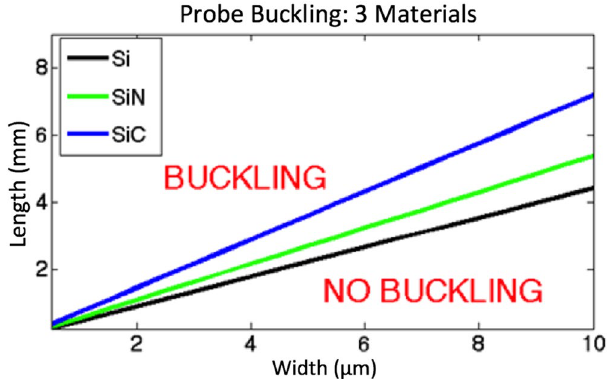
Figure 5. Critical length as a function of cross sectional size, considering silicon (E = 220 GPa), silicon nitride (E = 250 GPa), and silicon carbide (E = 450 GPa). One can see that a 3.5 mm long probe composed of silicon is expected to buckle at a width of approximately 6 μ m while the same probe, composed of SiC with the same geometry would not buckle. We assume here a conservative blunt tip geometry, as well as a pinned/fixed boundary condition (K = 2.045) instead of the fixed/fixed boundary condition (K =